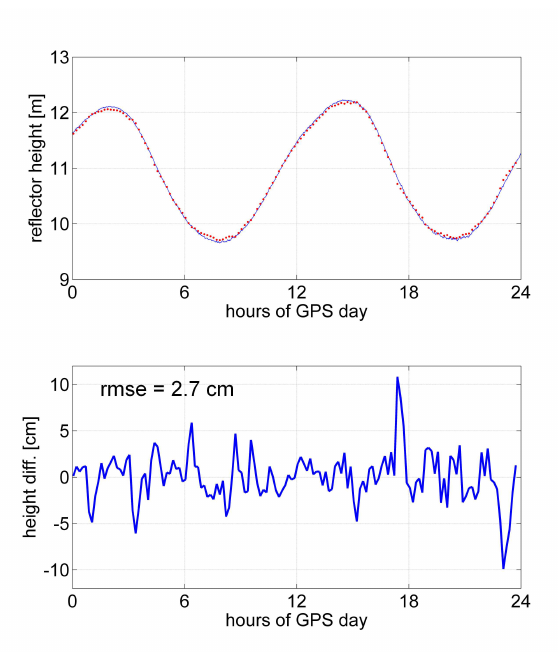
Figure 11: Resulting reflector heights. Top panel: calculated (red dots) and nominal values (blue line) of the reflector heights. Bottom panel: differences for all time